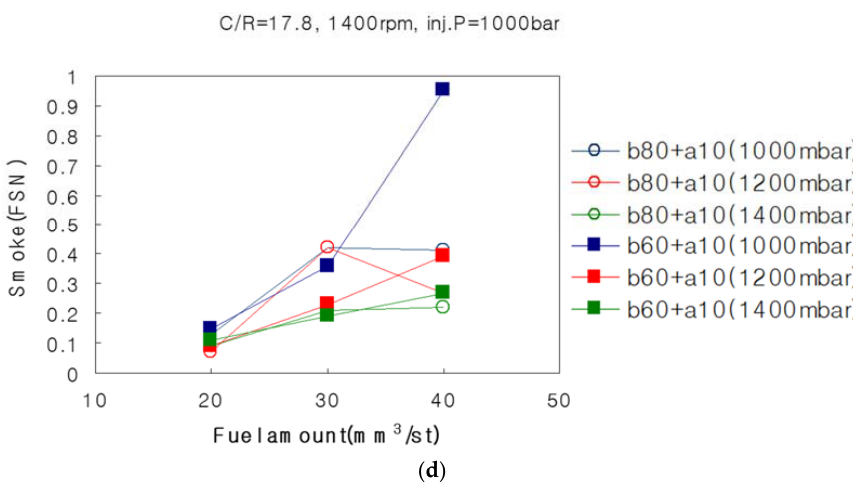
Figure 13. Characteristics of the exhaust emission in accordance with change the boost pressure. ( a ) Characteristics of NO x emission (injection timing, 1st inj.: BTDC 80°, 2nd inj.: ATDC 5°); ( b ) Characteristics of NO x emission (injection timing, 1st inj.: BTDC 80°, 2nd inj.: ATDC 10°); ( c ) Characteristics of smoke emission (injection timing, 1st inj.: BTDC 80°, 2nd inj.: ATDC 5°); ( d ) Characteristics of smoke emission (injection timing, 1st inj.: BTDC 80°, 2nd inj.: ATDC 10°).